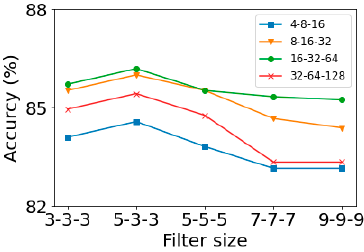
Figure 9. Performance of 1D CNN by varying the filter sizes and the number of filters.